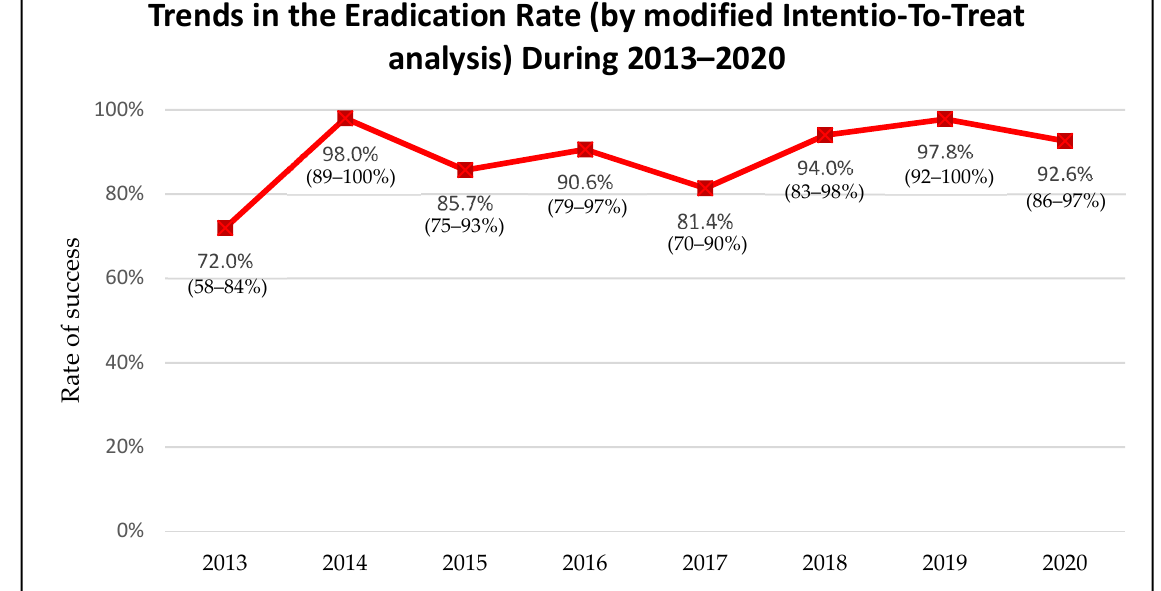
Figure 2. Trends in the H. pylori eradication rate during the years 2013–2020 (95% confidence intervals). The overall effectiveness of first-line standard triple therapy was 90% (95% CI: 86–92%) and was 92% (95% CI: 80–98%) of the main second-line therapy, consisting of PPI,